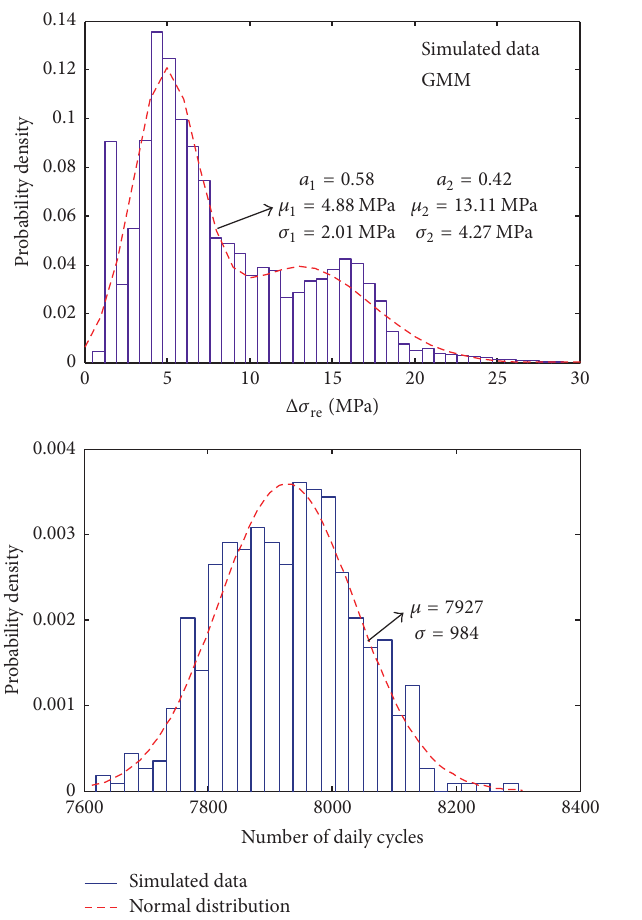
Figure 10: Probability density of the daily number of stress cycles.